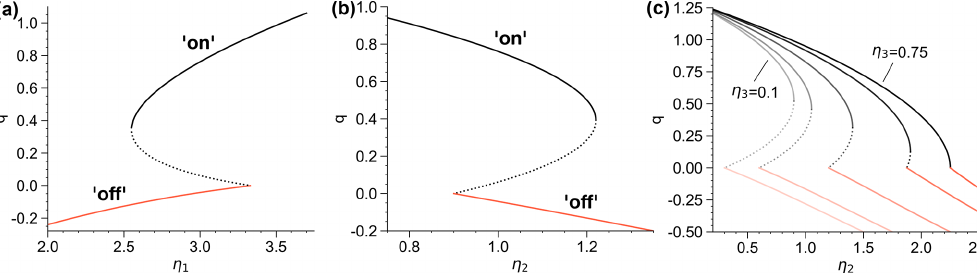
Figure 1. (a) Bifurcation diagram of the Stommel box model with η 1 as control parameter, η 2 = 1 . 0 and η 3 = 0 . 3. Solid lines indicate branches of stable fixed points, whereas dotted lines indicate unstable fixed (or saddle) points. (b) Bifurcation diagram with η 2 as control parameter, η 1 = 3 . 0 and η 3 = 0 . 3. (c) Dependence of bi-stability on η 3 ( η 1 = 3 . 0). The individual bifurcation diagrams with η 2 as control parameter are shown with decreasing bistability interval as η 3 is increased from 0.1 up to